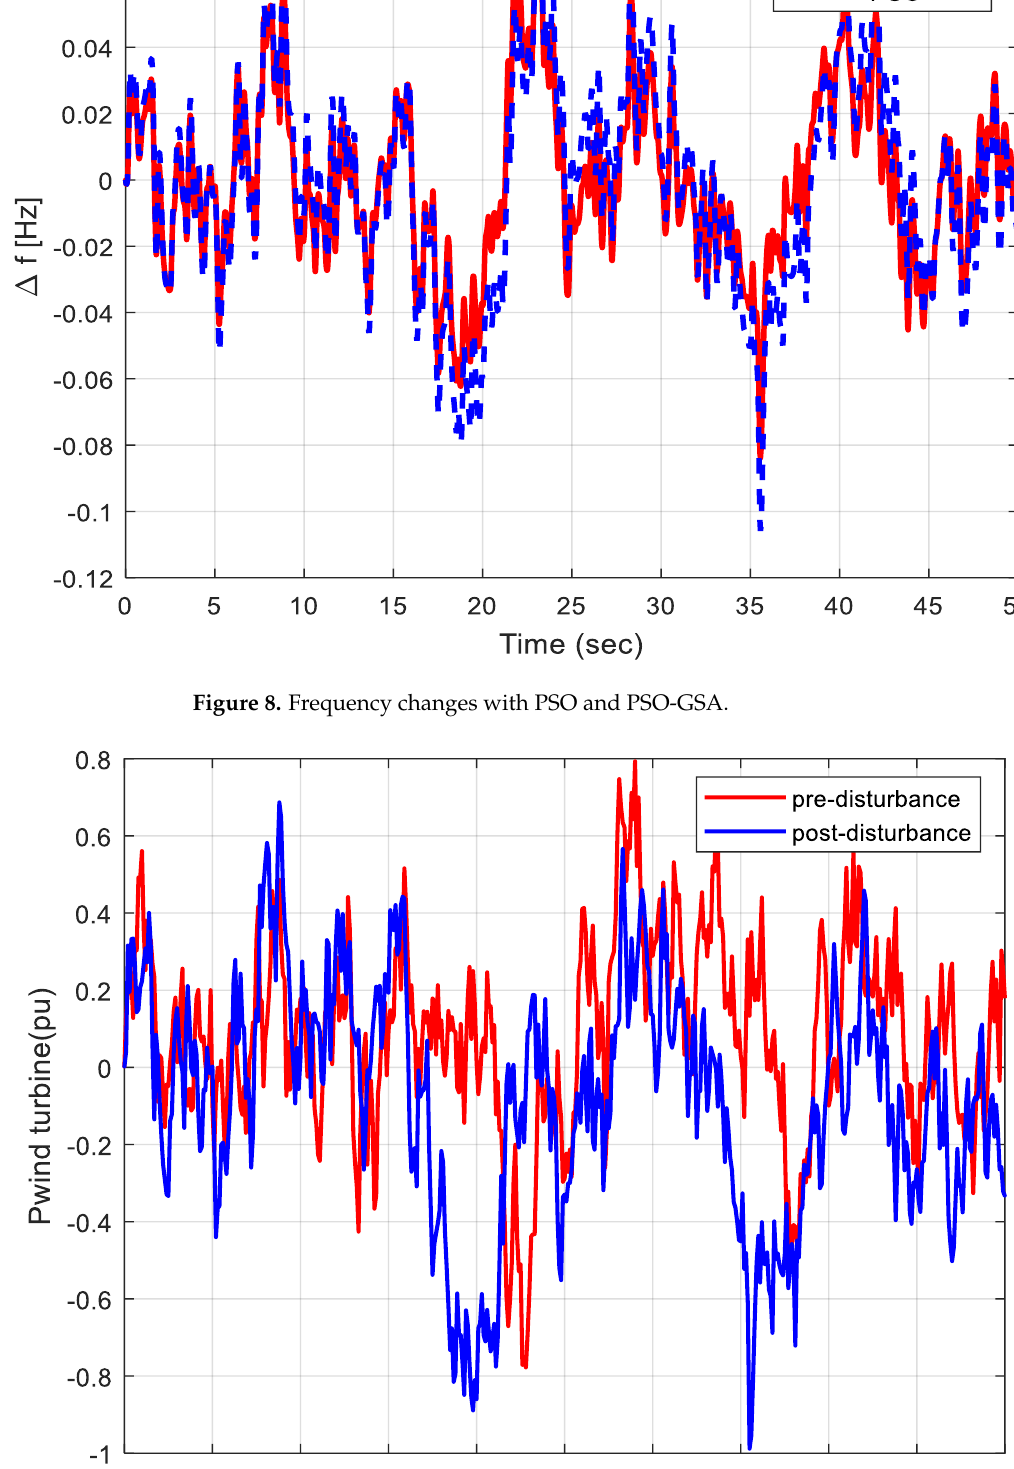
Figure 9. Wind turbine power (pre- and post-disturbance).